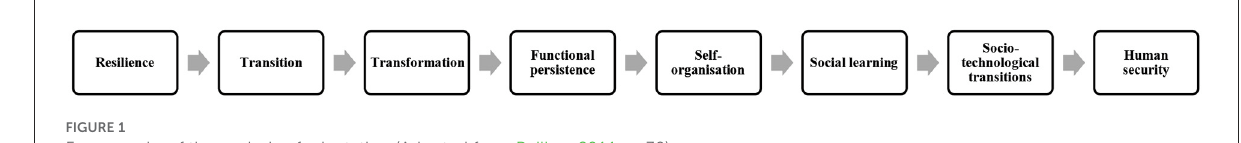
FIGURE1 Frameworks of the analysis of adaptation (Adopted from Peiling, 2011, p.